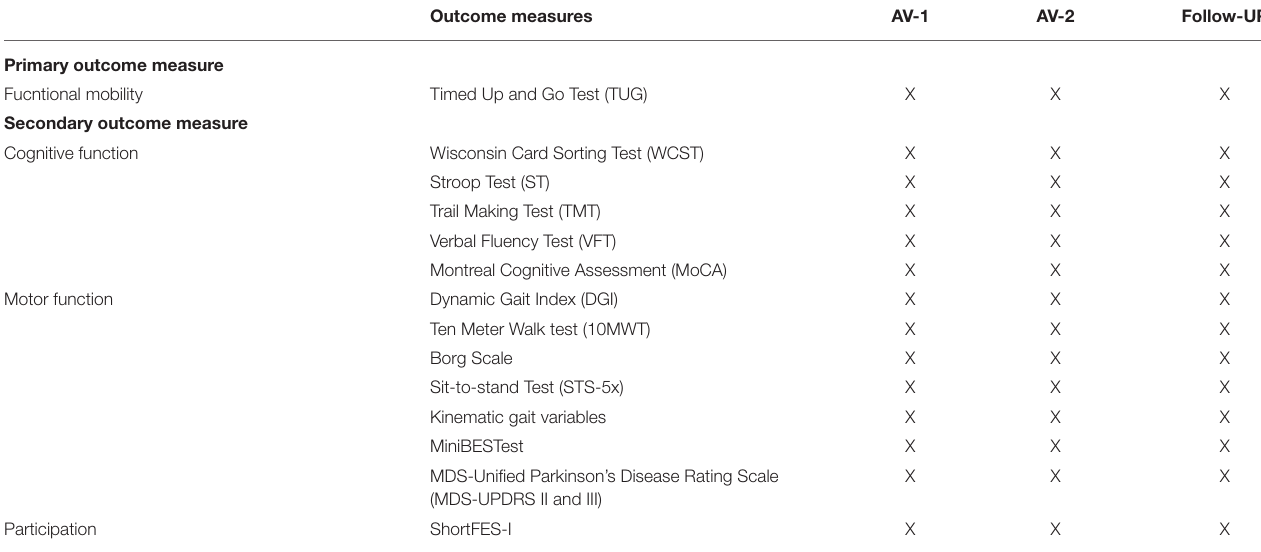
TABLE 1 | Primary and secondary outcome